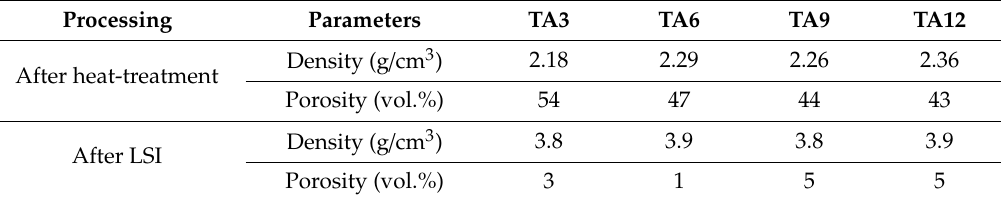
Table 1. Density and open porosity of all four samples before and after LSI.